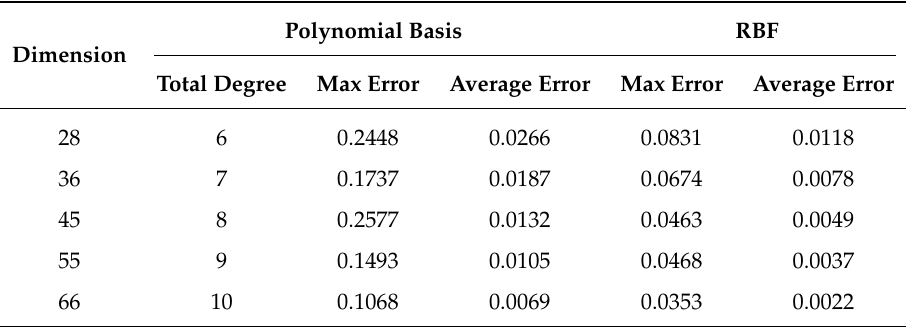
Table 6. The errors of least squares approximation based on different polynomial spaces and RBF space with the same dimension.